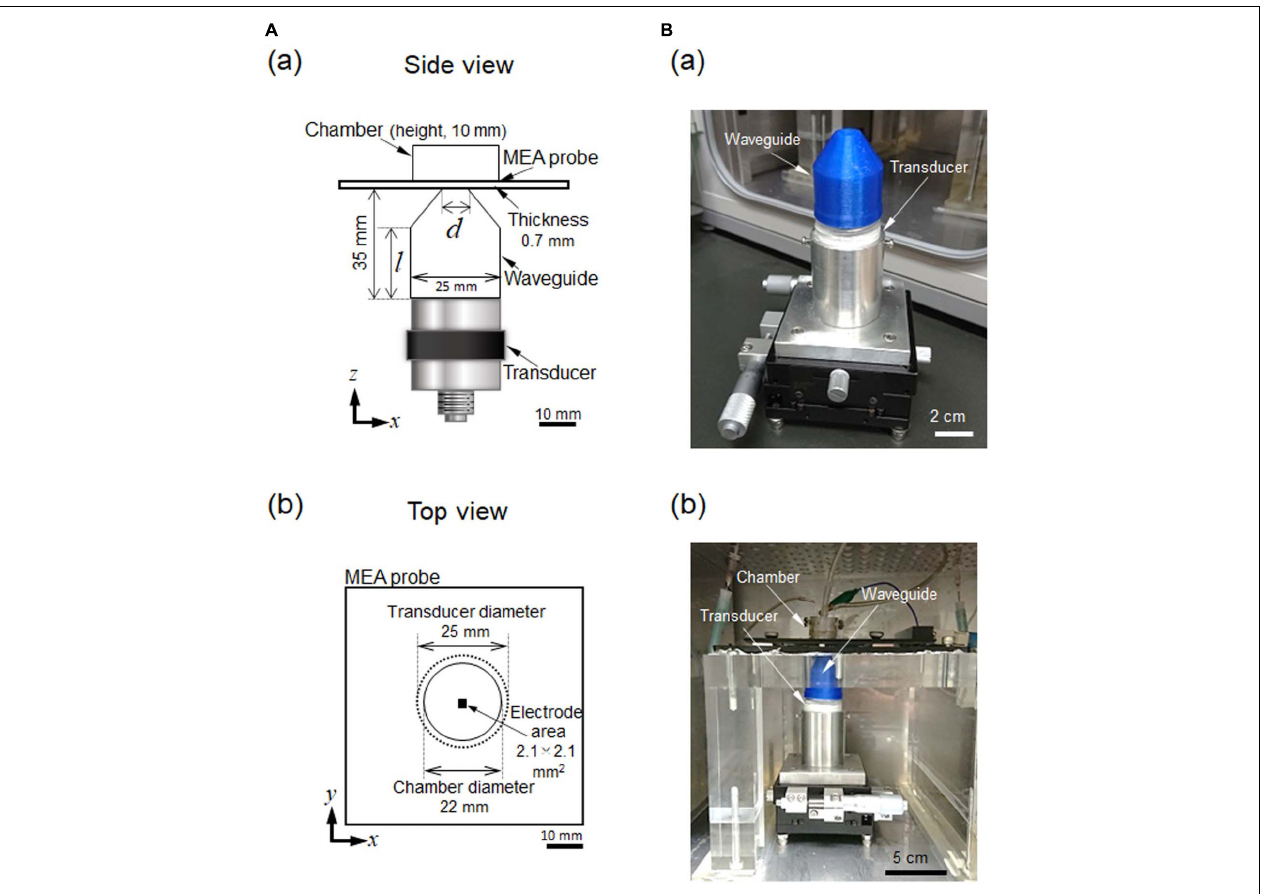
FIGURE 1 | Ultrasound stimulation and MEA-based recording system combined with an incubator. (A) In (a), a schematic side view of the experimental setup. A waveguide (collimator) was combined with an ultrasound transducer. An MEA probe was located at the upper-most part of the recording system The optimal diameter ( d ) of the waveguide and the length ( l ) of the cylindrical part were determined via numerical simulation. The sizes of the other parts were predetermined according to the structural and physical constraints of the system. In (b), a schematic top view of the experimental setup. The recording area of the MEA probe was positioned in the center of the transducer and the waveguide. (B) In (a), an image showing the waveguide and transducer. These two parts are held in a fixture and supported on an x - and y -axis translation stage, which enable the center of the transducer to be finely moved in the horizontal x - and y - directions. In (b), an image illustrating the locations of the parts of the measurement system in (a) in the incubator. Recording cables and perfusion tubes can be seen on the upper